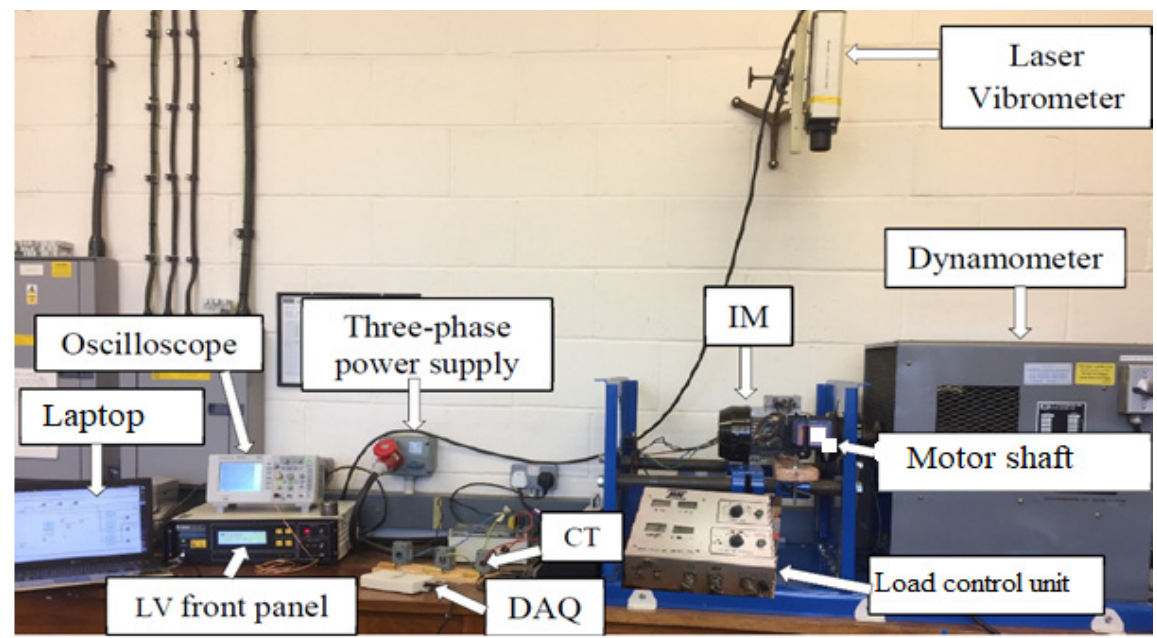
Figure 1. Signal measurement laboratory at the Cardiff University, UK.